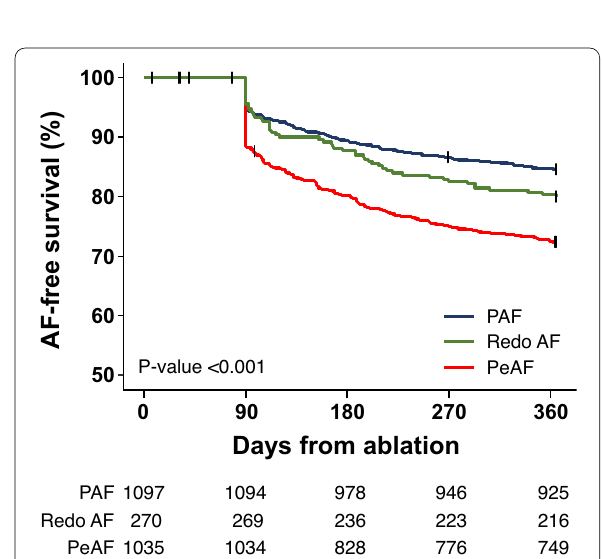
Fig. 3 Kaplan–Meier survival curve for recurrence of atrial tachyarrhythmia after AF catheter ablation. The patients with persistent AF showed the lowest AF free survival compared to the patients with paroxysmal AF and redo AF. There was no statistical difference between the patients with paroxysmal AF and redo AF. AF, atrial fibrillation; PAF, paroxysmal atrial fibrillation; PeAF, persistent atrial